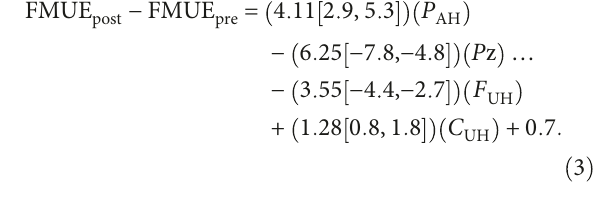
C T P F z , C z , and P z ), AH , AH , AH , and AH ), sagittal (